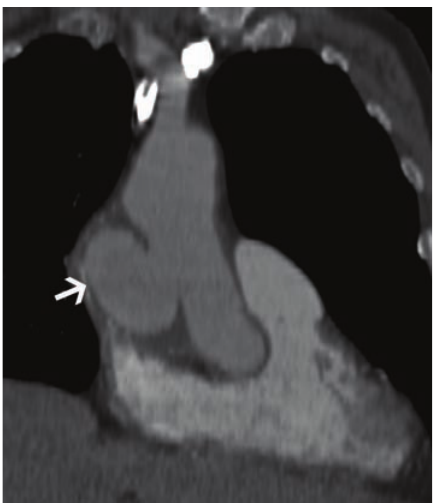
Figure 7: Pseudoaneurysm—coronal reconstructed CT image in a 53-year-old male following aortic surgery shows a pseudoaneurysm with narrow neck originating from the lateral aspect of the ascend- ing